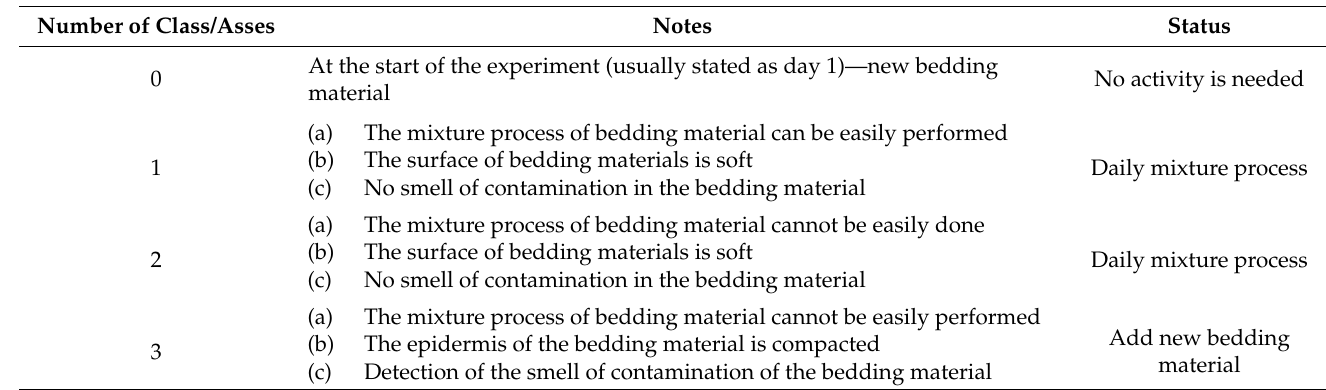
Table 5. Example of assessment of bedding